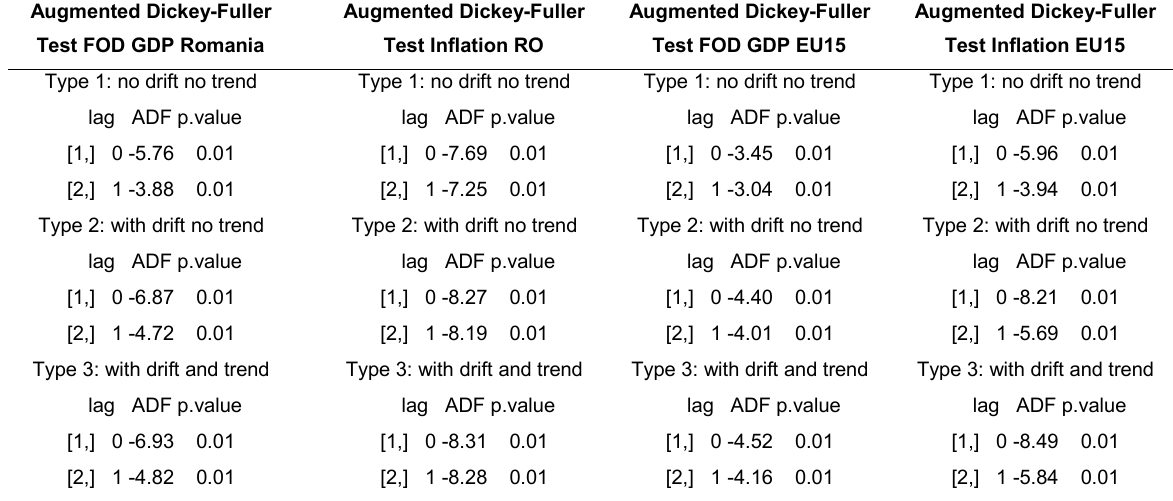
Table 2. Results of the Augmented Dickey-Fuller test for first-order difference (FOD) GDP and inflation for Romania and EU15 (1995-2019 sample). Note: only the case of these two economic entities has been included due to space constraints.